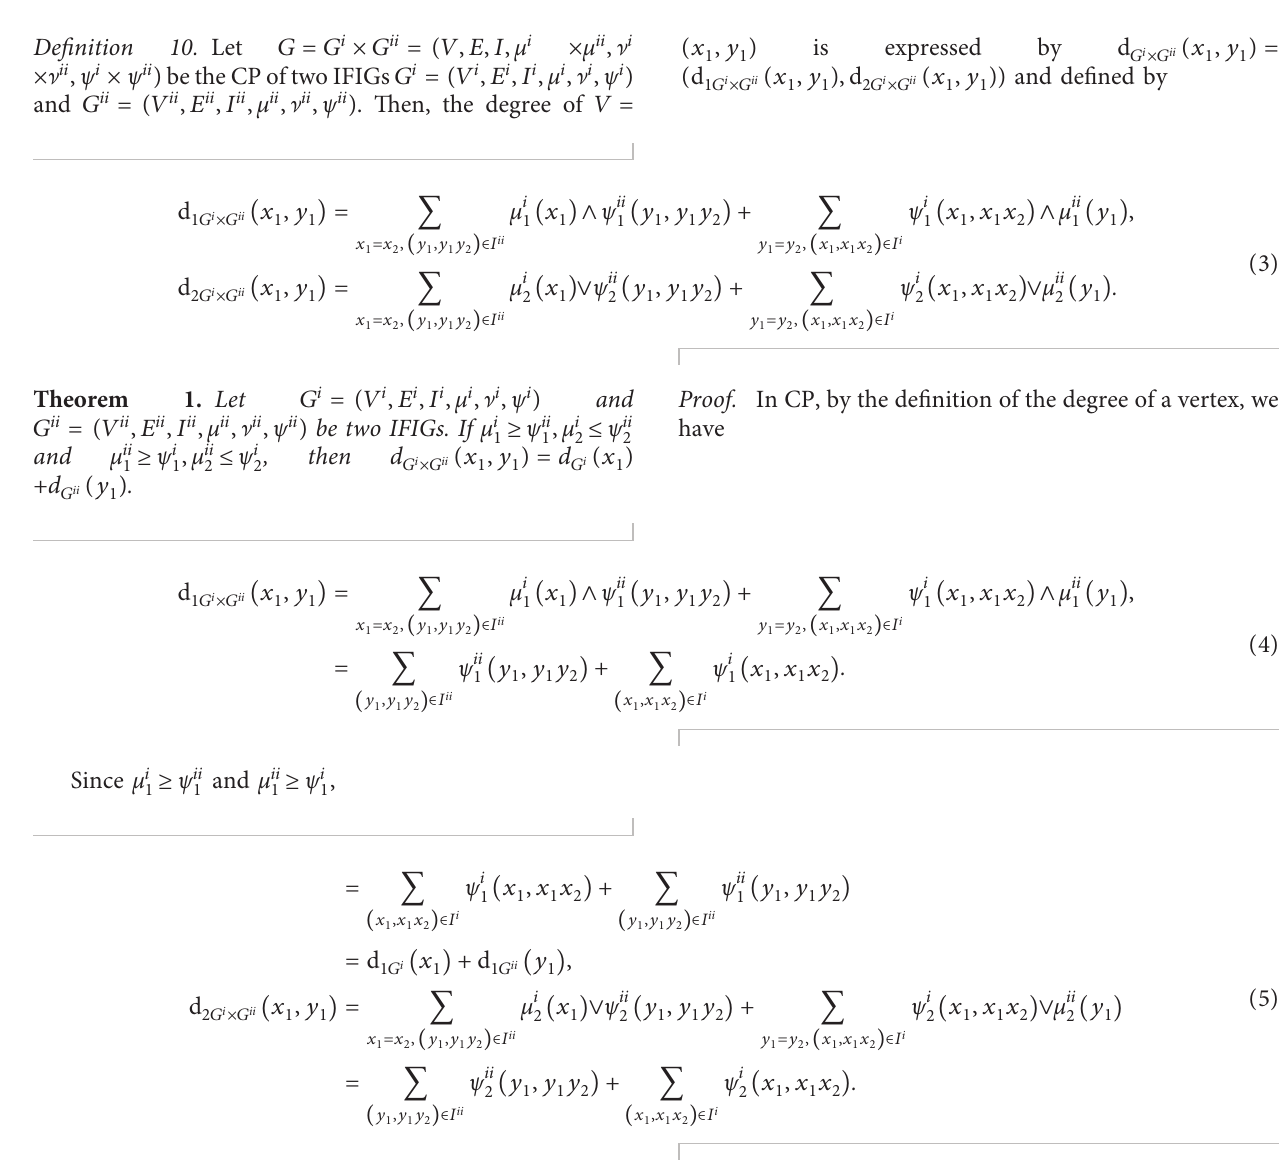
Figure 4: A network of different branches of the shopping